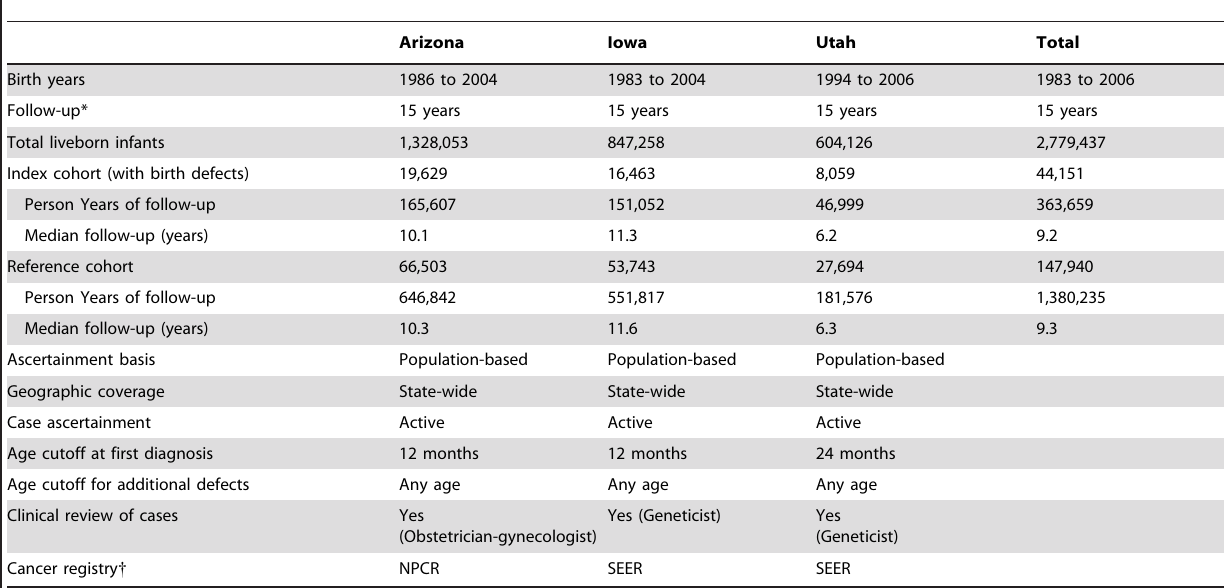
Table 1. Cohorts, follow-up time, and surveillance programs, UTAZIA study.